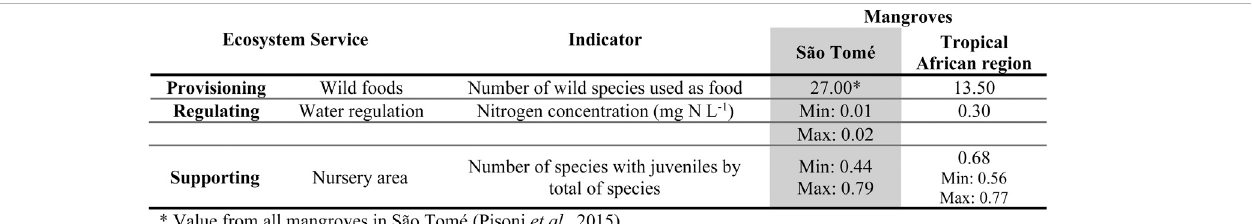
*value from all mangroves in são tomé (Pisoni et al., 2015)